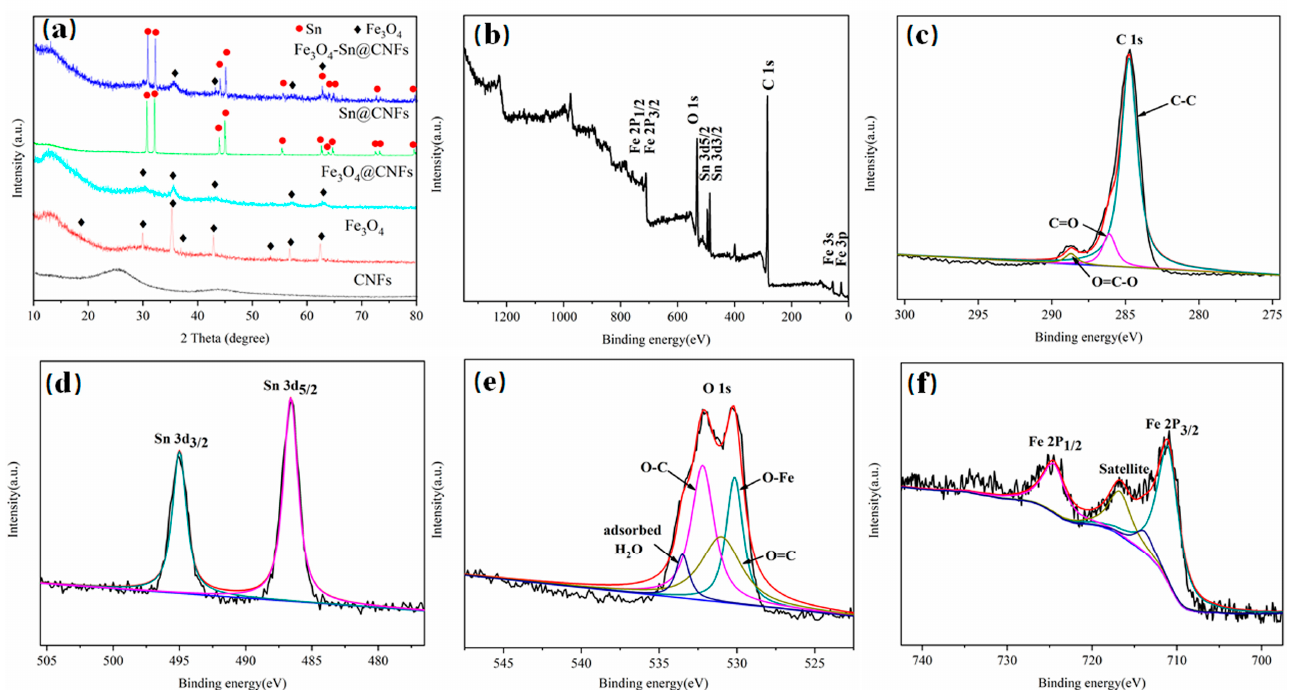
Figure 2. ( a ) The crystalline texture of CNFs, Sn@CNFs, Fe 3 O 4 , Fe 3 O 4 @CNFs, and Fe 3 O 4 -Sn@CNFs analyzed by X-ray diffraction (XRD). ( b – f ) The XPS pattern of Fe 3 O 4 @Sn-CNFs composite nanofibers and the different elements in different electron orbitals.